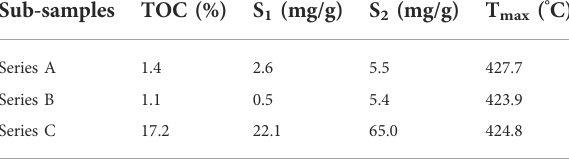
TABLE 2 TOC and pyrolysis parameters of